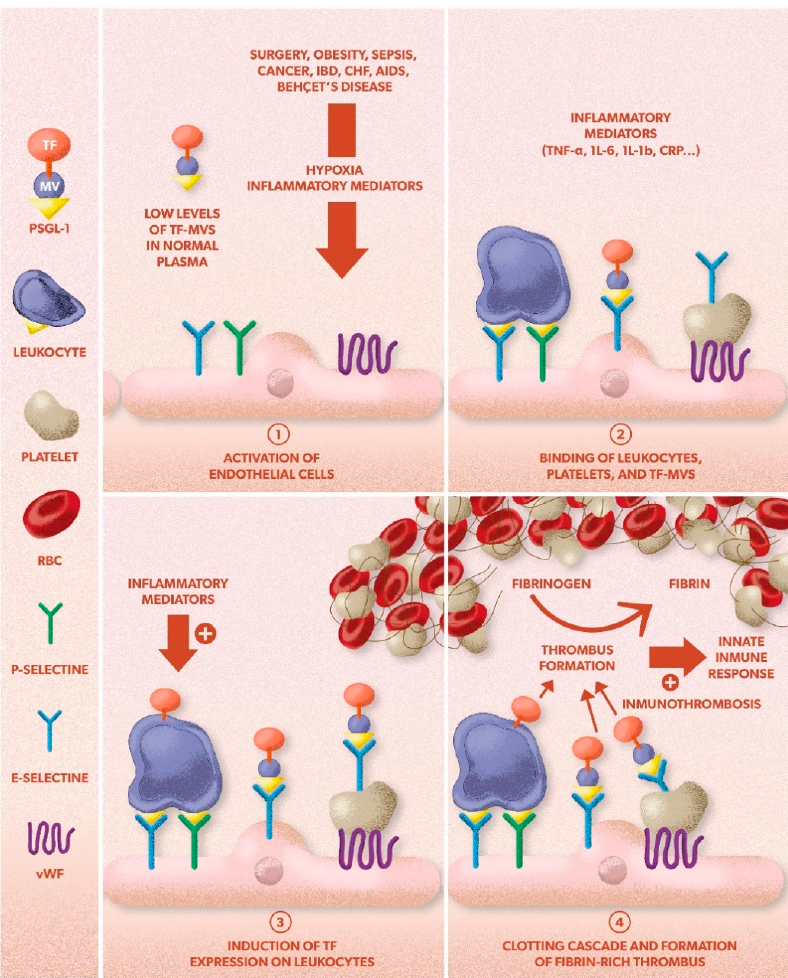
Figure 1. Proposed mechanisms for venous thrombosis. The formation of a venous thrombosis can be divided into distinct steps. ➀ The endothelium is activated by hypoxia and/or inflammatory mediators and expresses the adhesion proteins P-selectin, E-selectin, and vWF. ➁ Circulating leukocytes, platelets, and TF-MVs bind to the activated endothelium. ➂ The activation of endothelial cells, platelets, and leukocytes with the subsequent formation of MVs can trigger the coagulation system through the induction of TF. (cid:175) The local activation of the coagulation cascade overwhelms the protective anticoagulant pathways and triggers thrombosis. The fibrin-rich clot also contains platelets and red blood cells. AIDS: acquired immunodeficiency syndrome; CHF: congestive heart failure; CTEPH: chronic thromboembolic pulmonary hypertension; DVT: deep vein thrombosis; HR: hazard ratio; IBD: inflammatory bowel disease; MVs: microvesicles; PE: pulmonary embolism; PPV: predictive positive value; PTS: post-thrombotic syndrome; RV: right ventricle; TF: tissue factor; vWF: von Willebrand factor. Adapted from: Mackman N. New insights into the mechanisms of venous thrombosis. J Clin Invest. 2012;122(7):2331-6. Erratum in: J Clin Invest. 2012;122(9):3368. With permission from American Society for Clinical